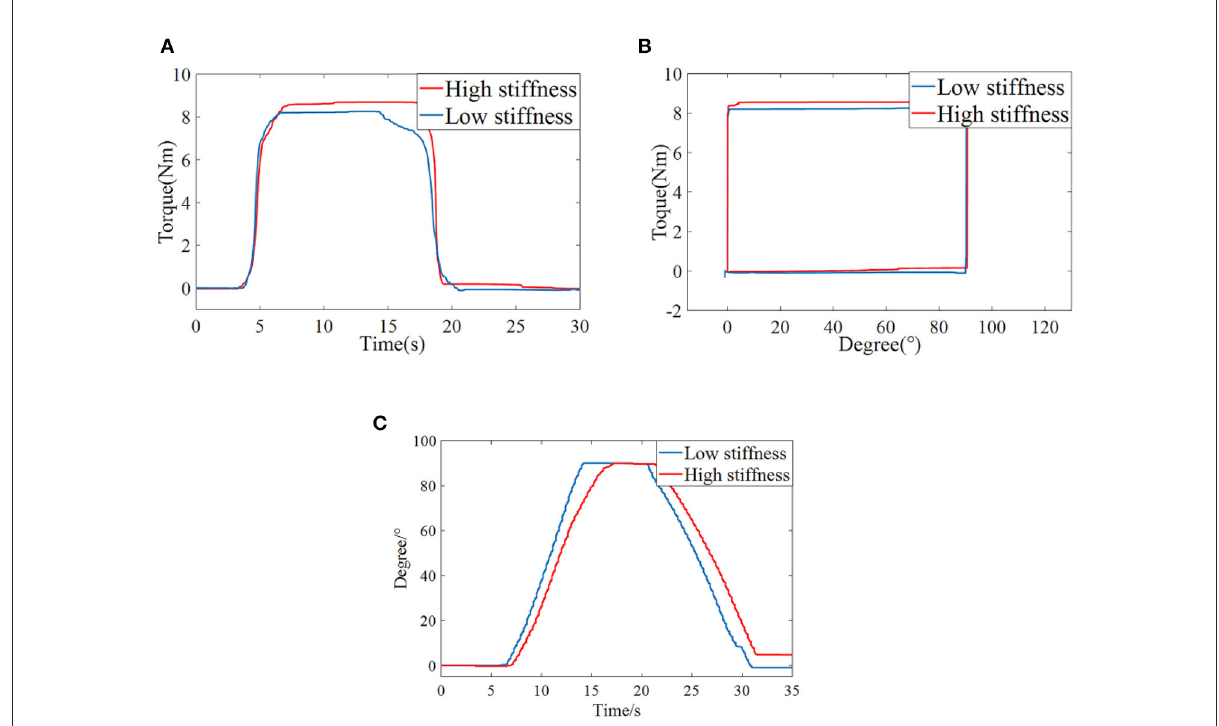
FIGURE14 Elbow isotonic centripetal resistance training (A) Torque-Time curve (B) Torque-Angle curve (C) Angle-Time curve.